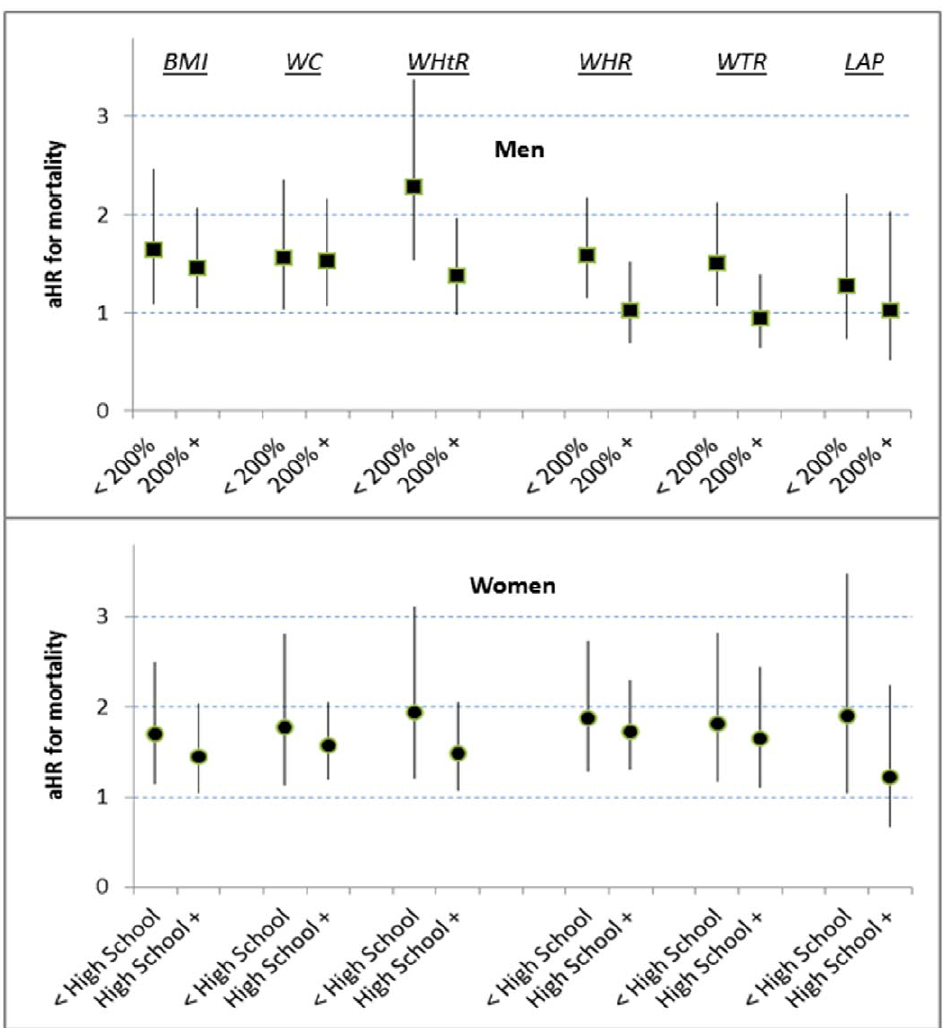
Figure 3. Interactions with socioeconomic position (poverty-income ratio or high-school completion) for mortality risk at p75, by 6 adiposity indicators. (aHR=multiply adjusted hazard